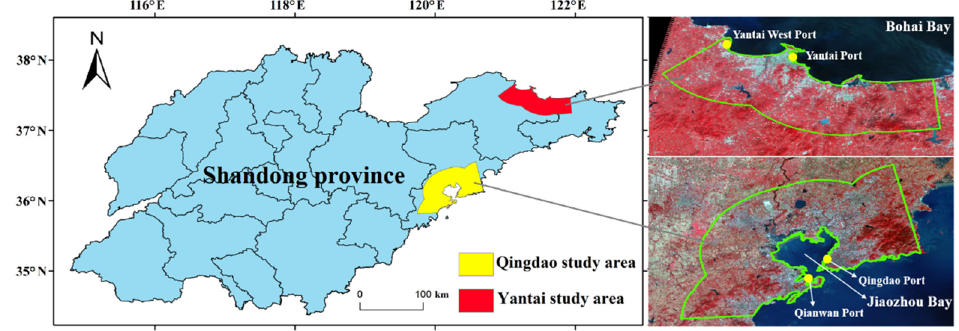
Figure 1. Geographic distribution map of the study area (Landsat-8 OLI image, 2020) .